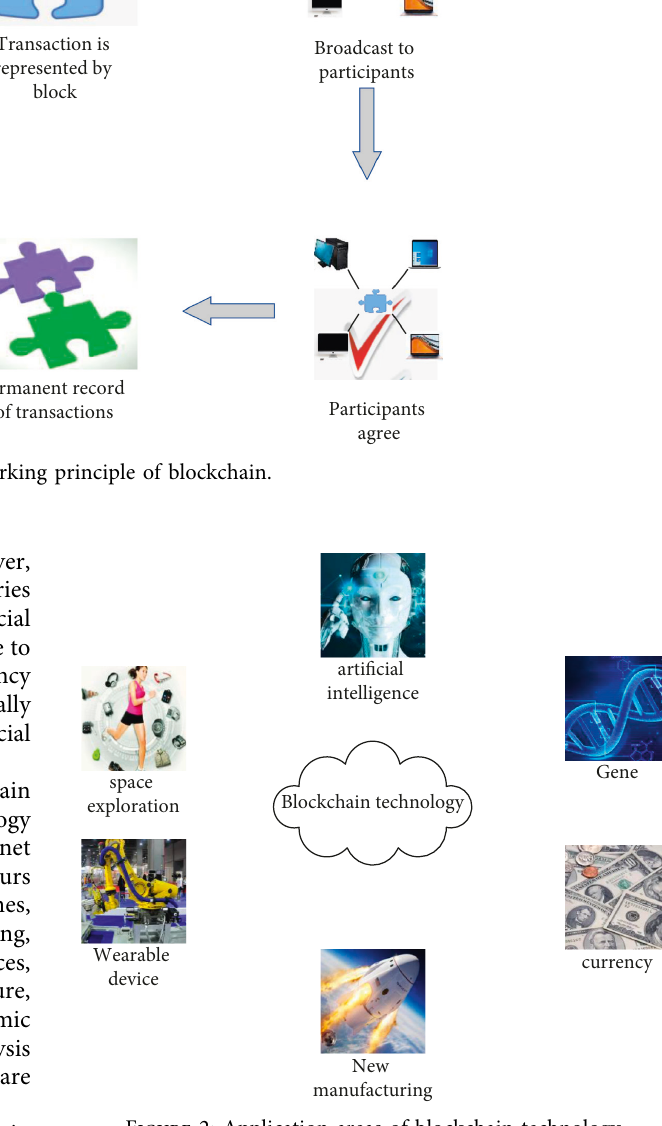
Figure 2: Application areas of blockchain